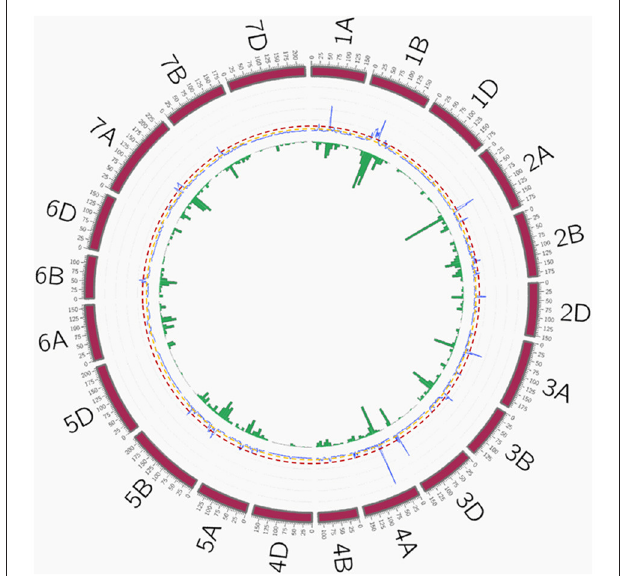
FIGURE 5 | QTL overview index. The index values are represented along chromosomes as a blue line. Yellow and red dashed lines represent the thresholds for average (0.7) and higher values (3.5), respectively. Green bars below the QTL overview index represent the number of significant MTAs per 10cM (–log 10 P > 3). QTL, quantitative trait loci; MTAs, marker–trait